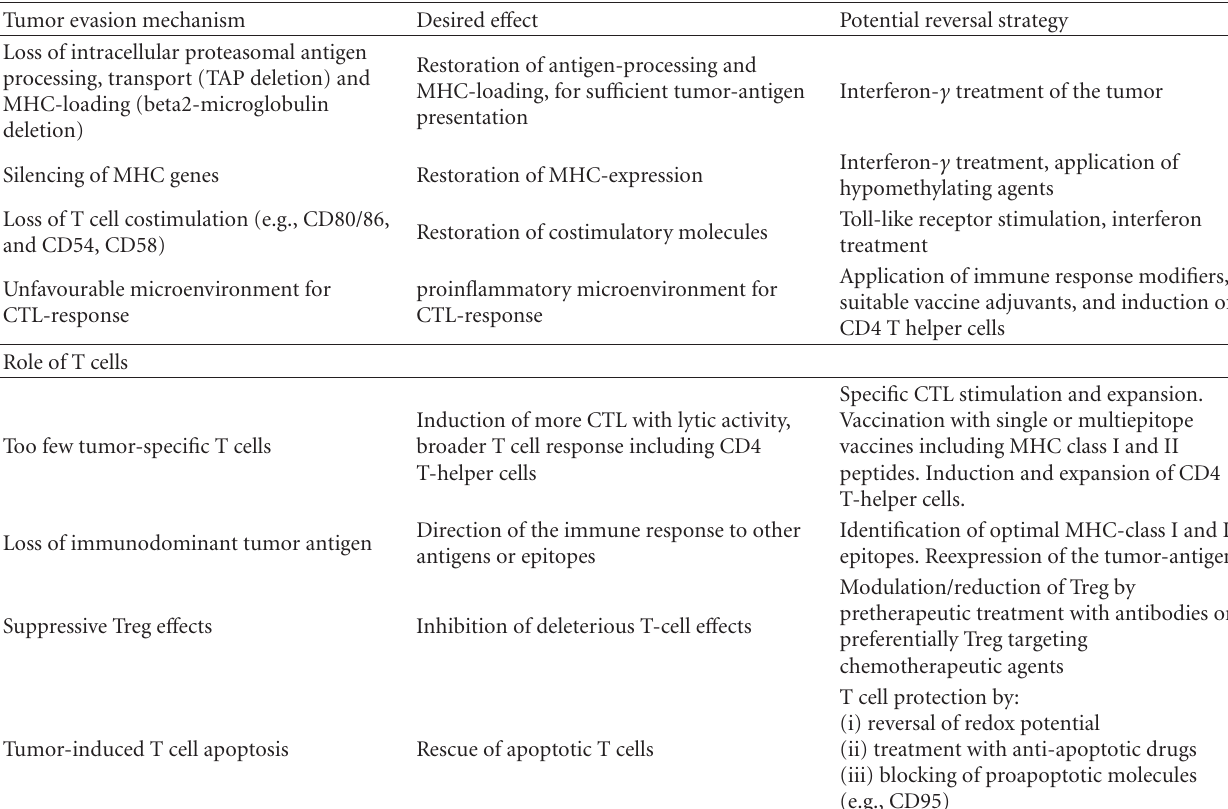
Table 1: Tumor escape and potential reversal strategies by adjuvant treatment